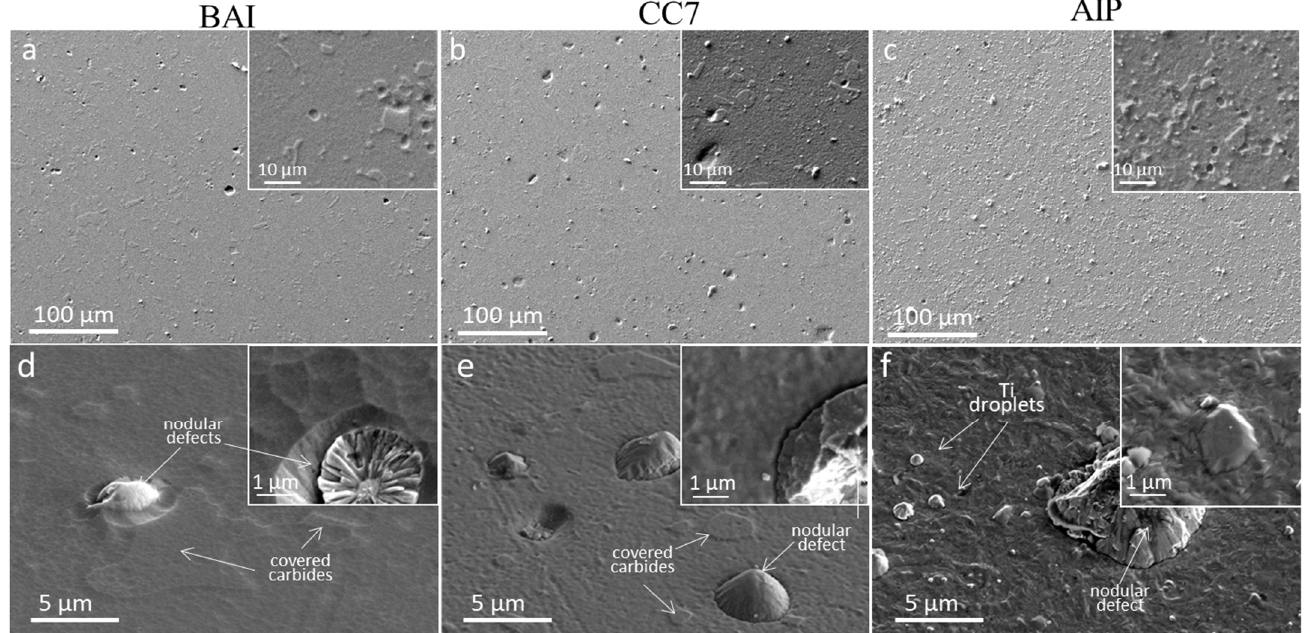
Figure 3. Top-view SEM images of TiN hard coatings deposited onto D2 tool steel substrate in BAI, CC7 and AIP deposition systems. The upper SEM images ( a – c ), including insets, were recorded at low magnifications, while the lower images ( d – f ), including insets, were taken at high magnification and by tilting the sample approximately 20°.